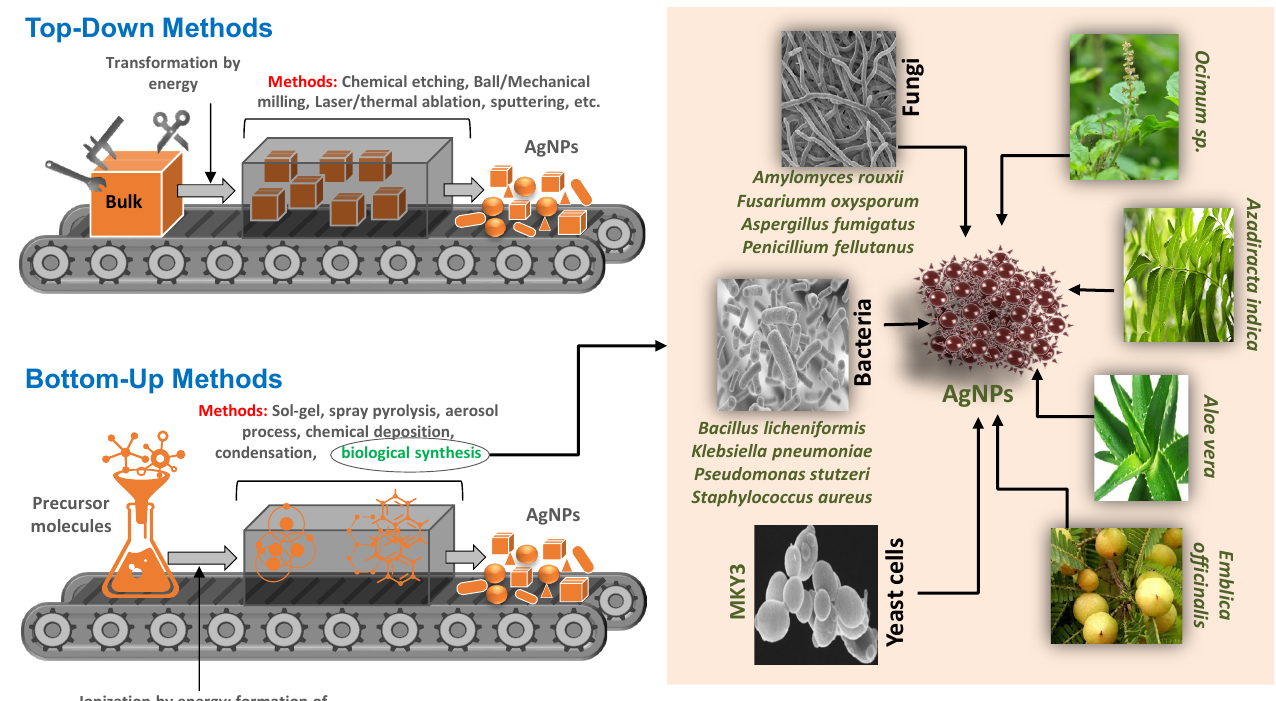
Figure 1. Illustration of two approaches of synthesis of AgNPs in left panel: (i) top-down approaches such as mechanical, chemical, and electro-explosion, etc. In bottom-up approaches, inorganic or organic substances are used as a reducing or capping agents. In bottom-up approaches, various techniques, i.e., superficial fluid synthesis, aerosol process, green synthesis (using bacteria, algae, fungi and plant or their biological products) etc. are used. Right panel shows a few proven examples of microbes and plants for AgNPs